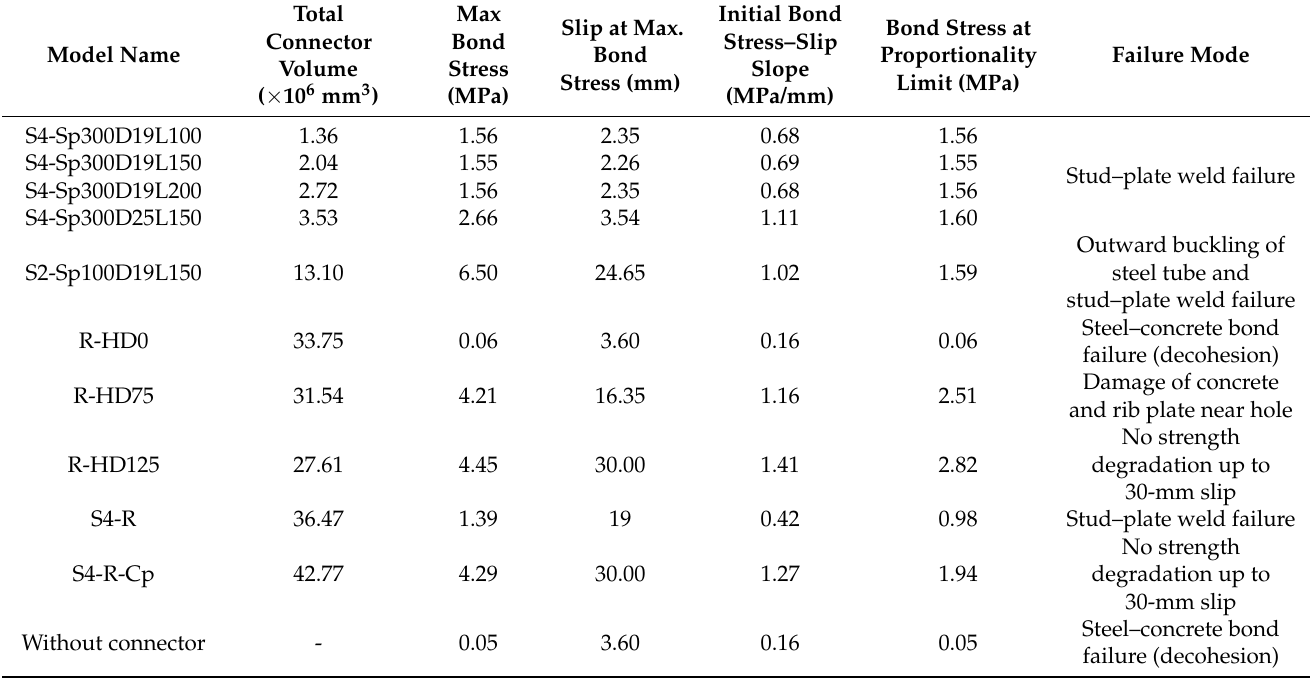
Table 4. Summary of finite element analysis